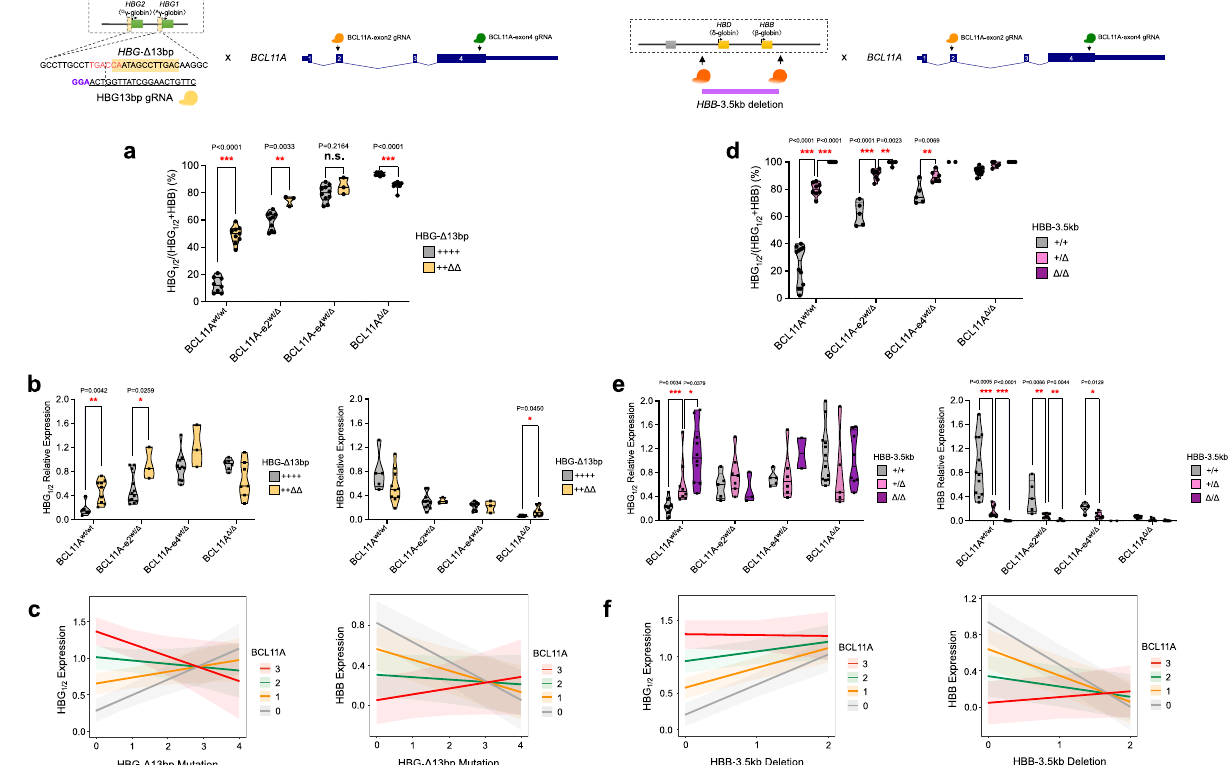
Fig. 2 Functional genetic interactions between BCL11A and β -globin locus cis -regulatory elements. a , b Globin gene expression analysis in BFU-E colony upon combined perturbation of HBG - Δ 13bp and BCL11A. BCL11A-e2 Δ : frameshift mutation in BCL11A exon 2; BCL11A-e4 Δ : frameshift mutation in BCL11A exon 4; HBG Δ : editing mutation within HBG - Δ 13bp region. Results are shown as violin plot ( P values are labeled on the top of each comparison. * P < 0.05, ** P < 0.01, *** P < 0.001 by a two-tailed Student ’ s t test). c Quantitative modeling on HBG1 / 2 or HBB mRNA expression from combined perturbation of HBG - Δ 13bp and BCL11A. HBG - Δ 13bp mutation (0: ++++ ; 1: +++ Δ ; 2: ++ ΔΔ ; 3: + ΔΔΔ ; 4: ΔΔΔΔ ); BCL11A mutation (0: BCL11A wt/wt ; 1: BCL11A-e2 wt/ Δ ; 2: BCL11A-e4 wt/ Δ ; 3: BCL11A Δ / Δ ). Modeling lines and bands are shown as mean ± 95% CI. d , e Globin gene expression analysis in BFU-E colony upon combined perturbation of HBB -3.5kb element and BCL11A. Results are shown as violin plot ( P values are labeled on the top of each comparison. * P < 0.05, ** P < 0.01, *** P < 0.001 by a two-tailed Student ’ s t test). f Quantitative modeling on HBG1 / 2 or HBB mRNA expression from combined perturbation of HBB- 3.5kb element and BCL11A. HBB- 3.5kb deletion (0: + / + ; 1: + / Δ ; 2: Δ / Δ ); BCL11A mutation (0: BCL11A wt/wt ; 1: BCL11A-e2 wt/ Δ ; 2: BCL11A-e4 wt/ Δ ; 3: BCL11A Δ / Δ ). Modeling lines and bands are shown as mean ± 95% CI. NATURE COMMUNICATIONS| (2021) 12:4991